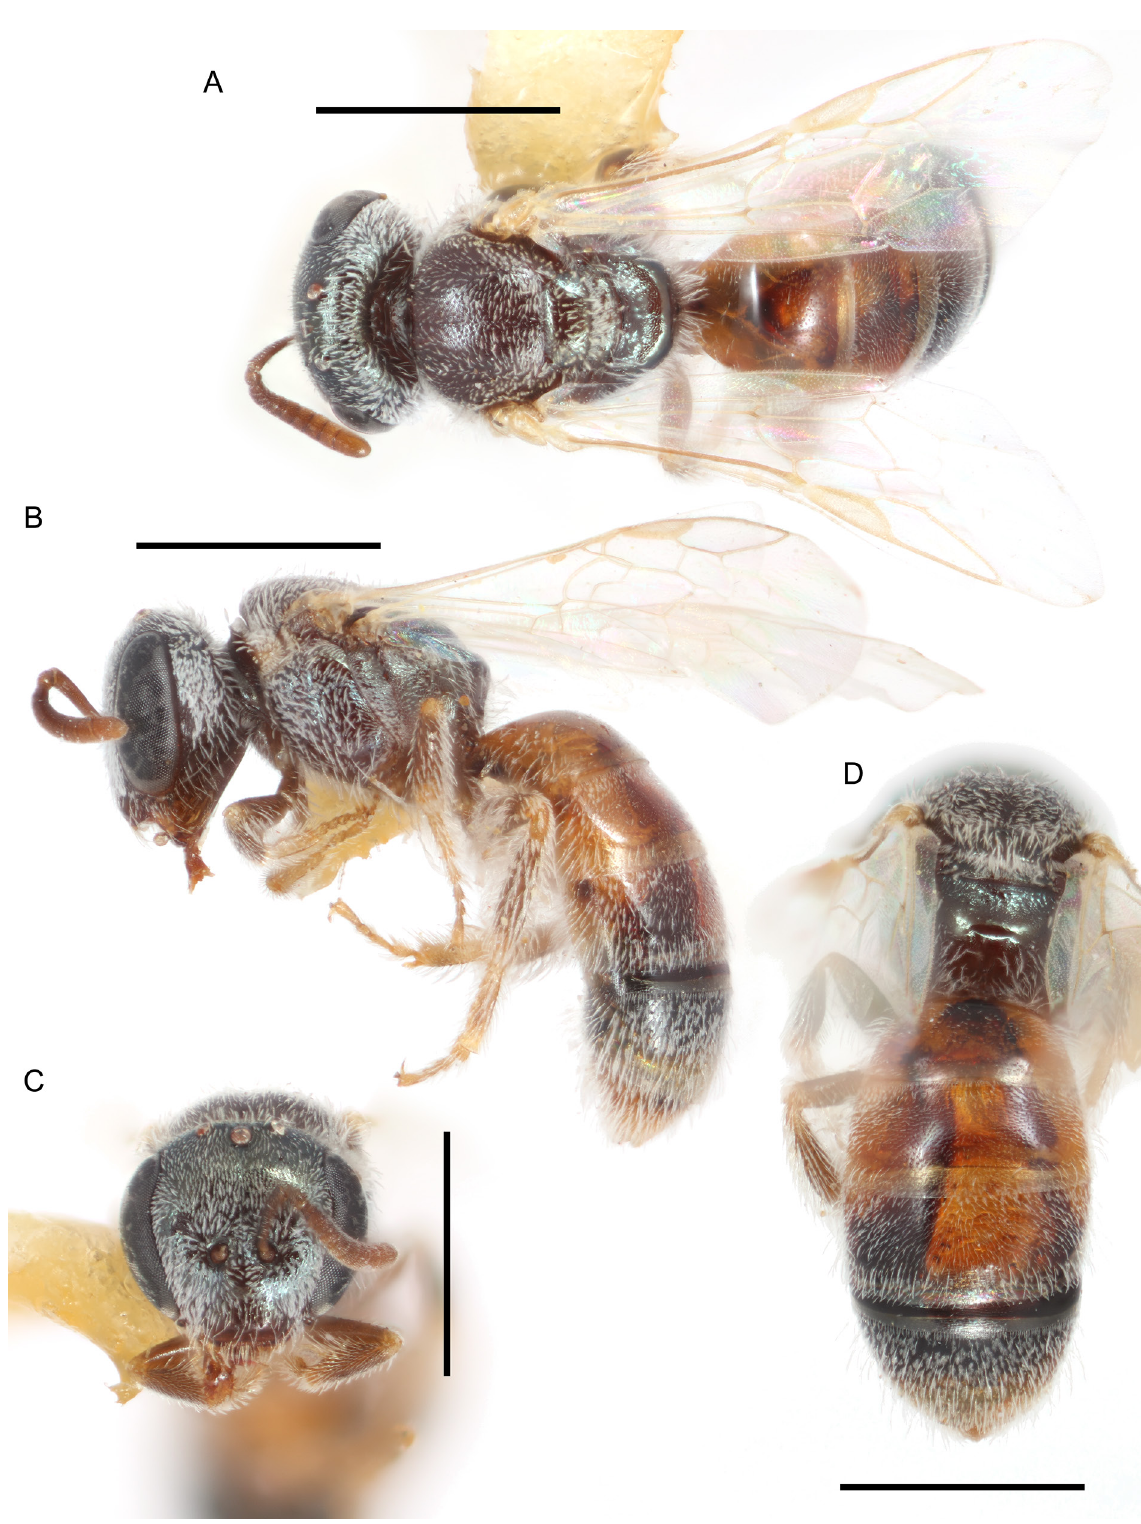
Fig. 70. Lasioglossum ( D. ) perditum sp. nov., ♀. A . Dorsal habitus. B . Lateral habitus. C . Face. D . Propodeum and metasoma. Scale bars: 1 164